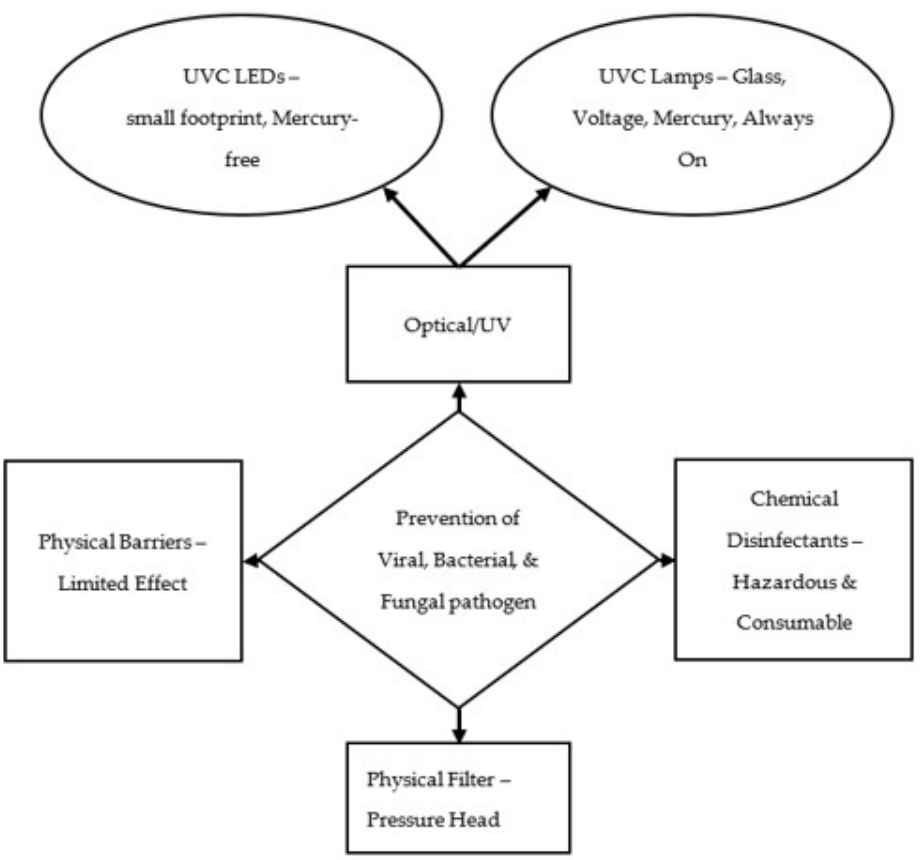
Figure 1. A map of the field of prevention of the transmission of airborne pathogens in enclosed spaces with a focus on UVC and weaknesses of competing technologies.